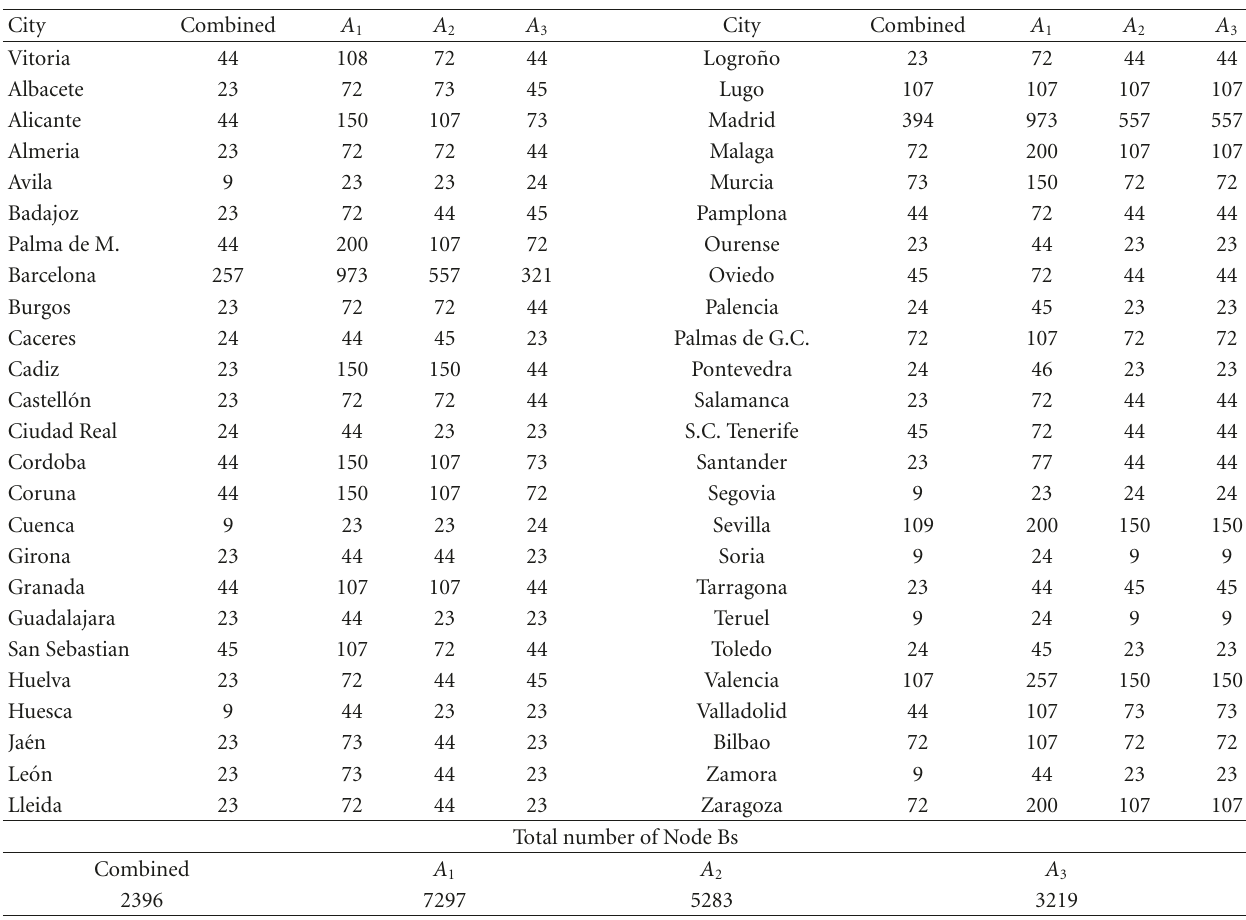
Table 15: Resulting number of Node B’s.